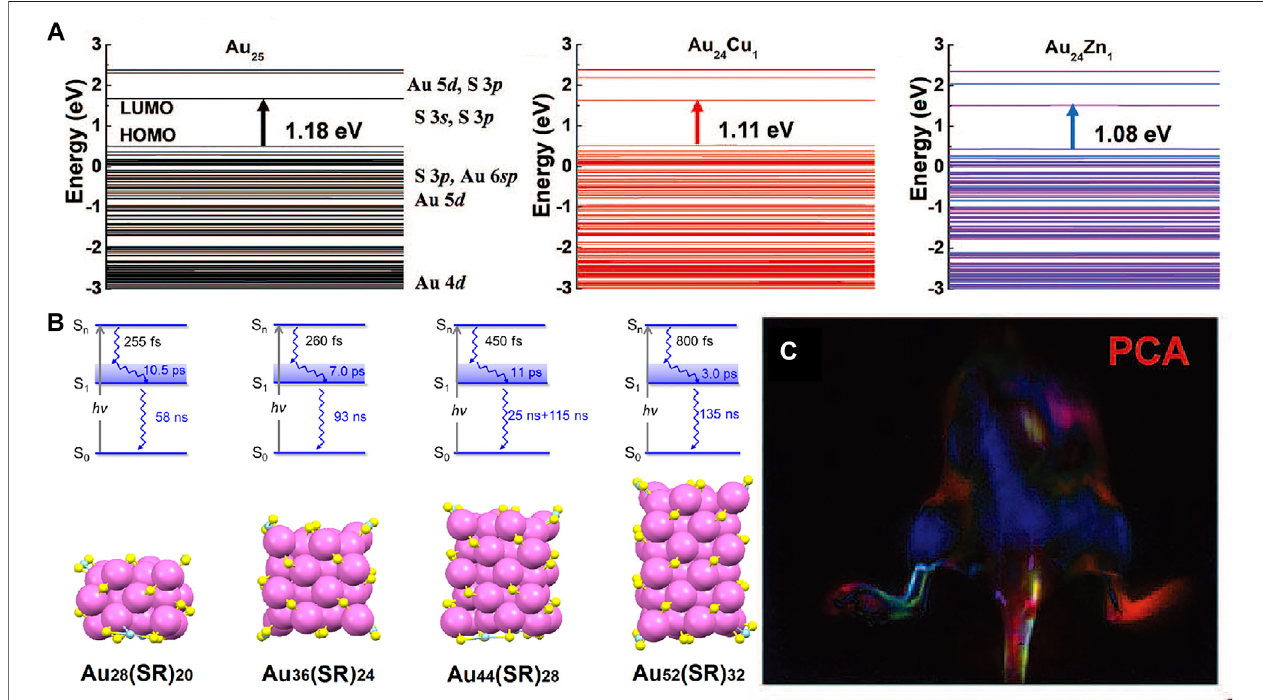
FIGURE 4 | (A) Schematic of the energy level of Cu and Zn doped Au 25 clusters by density functional theory (Liu et al., 2019). Reproduced with permission from Zhanget al.(2019). (B) Relaxationmodeland thecorrespondingAu m (SR) n nanoclustercrystal structures (Zhou etal.,2017).Reproduced withpermission fromJinetal. (2017). (C) DynamicNIR-II fl uorescenceimagingoflymphaticmetastasis withAu 25 clustersandprincipalcomponentanalysisimages(Liuetal.,2019).Reproduced with permission from Zhang et al.